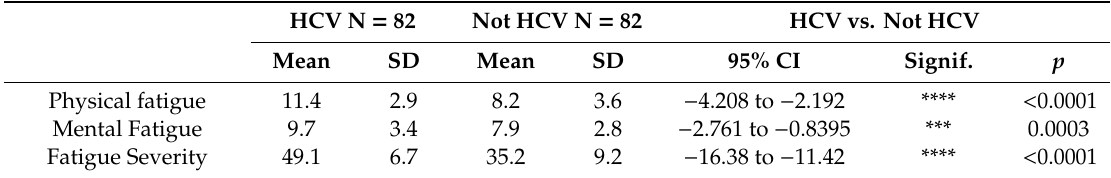
Table 4. Fatigue